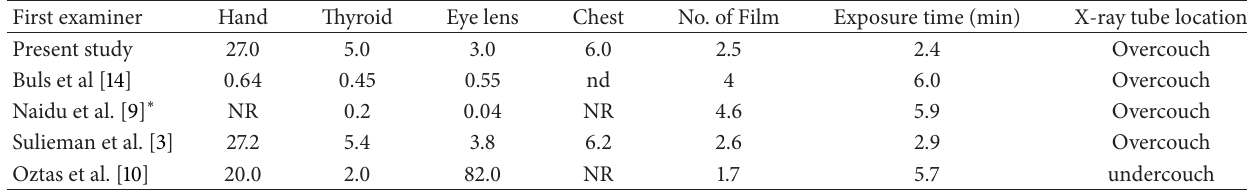
Table 7: The mean radiation doses for the first examiner during ERCP procedure ( 𝜇 Gy).